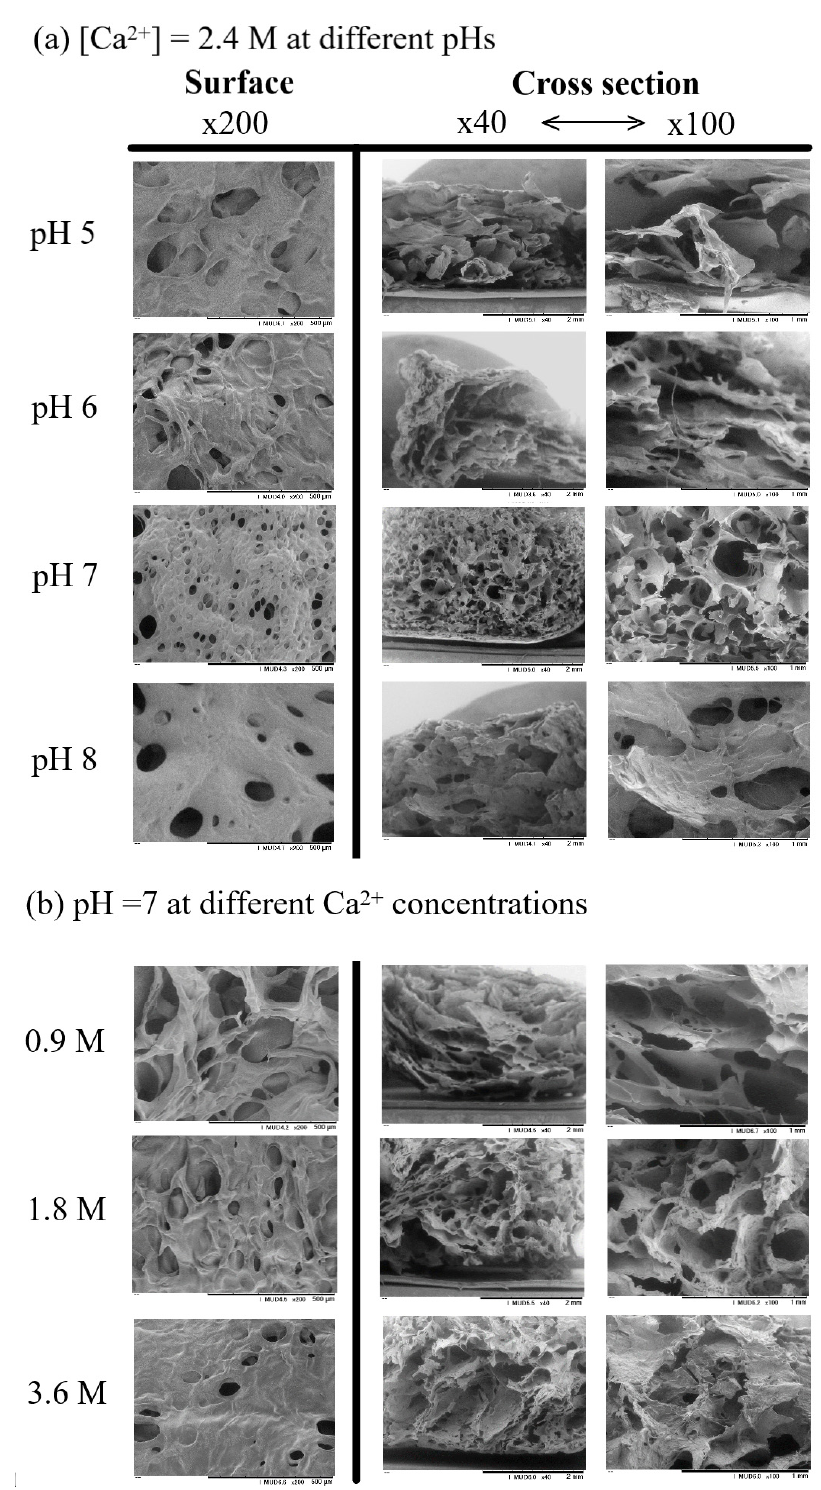
Figure 7. Surface and cross-section scanning electron microscopic (SEM) images of pectin hydrogel prepared at pH 5 to 8 ( a ); 0.9 M, 1.8 M, and 3.6 M Ca 2+ solutions ( b ). Surface images in 200 × g magnification. Cross-section images in 40 × g and 100 × g